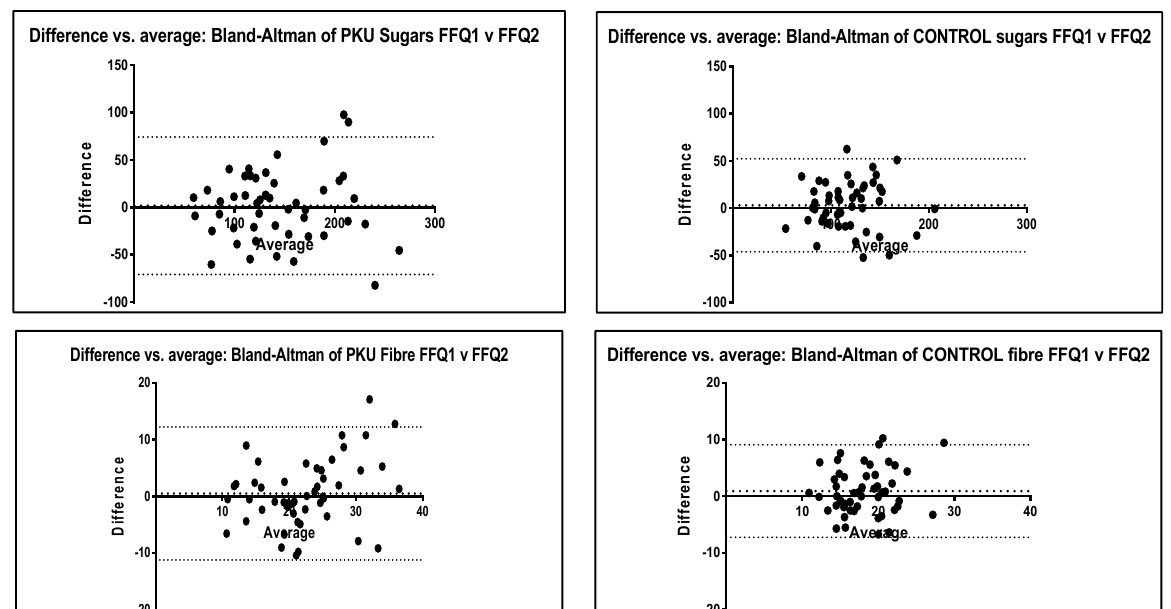
Figure 2. Bland–Altman plots for PKU and control group macronutrient intake FFQ 1 v FFQ 2. bias line (mean); upper and lower levels of agreement 95% confidence (2 SD). CHO = carbohydrate. 3.5.2. Criterion Validity (Comparison with an Existing Standard)—FFQ vs. Dietary re- calls